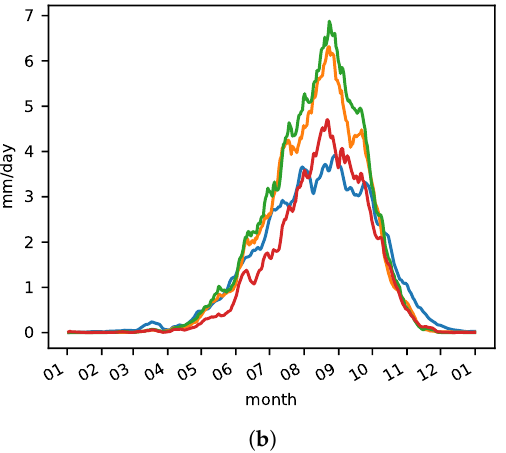
Figure 3. ( a ) Guinea and ( b ) Sahel daily rainfall time series with a 10-days running mean for the model (blue), satellite (orange) and rain-gauge (green)